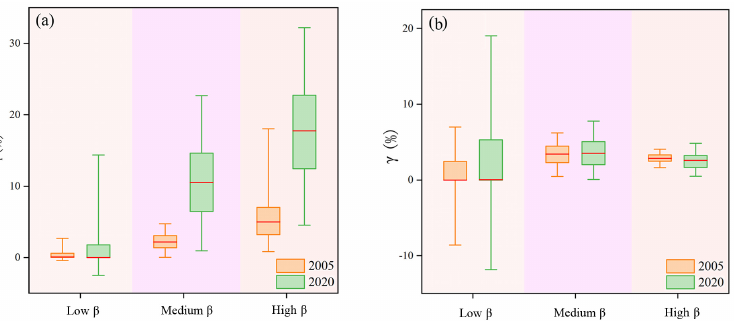
Figure 9. Indirect impact ( a ) of urbanization on vegetation and growth offset ( b ) with different levels of urbanization in 2005 and 2020.